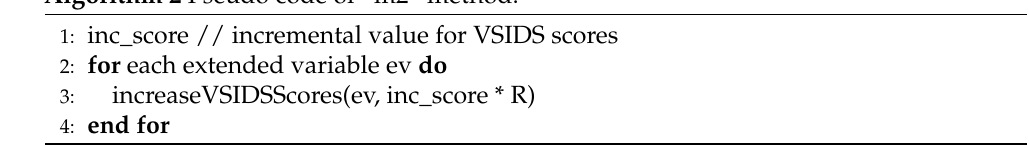
Algorithm 2 Pseudo code of “m2”